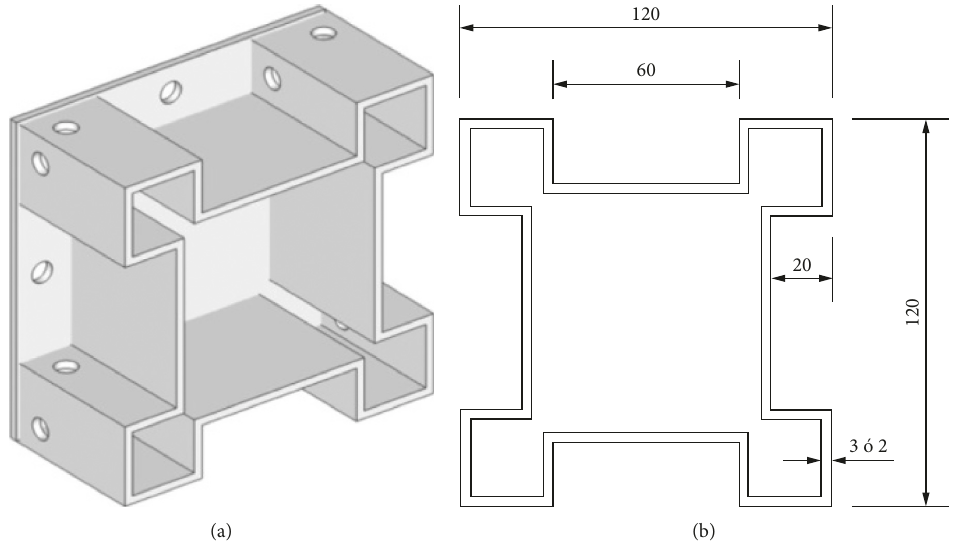
Figure 4: (a) Proposed cross section. (b) External dimensions 120 ×